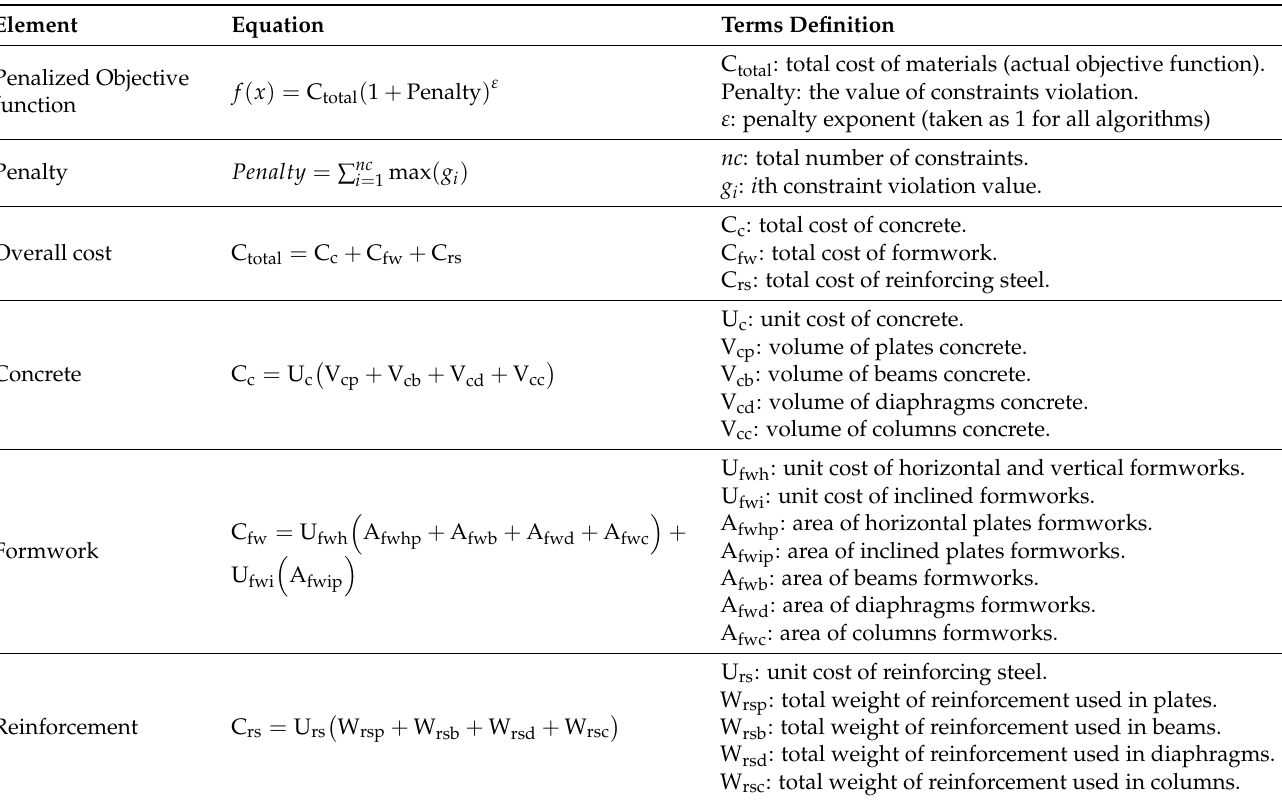
Table 6. Expressions used to calculate the objective function, penalty, and costs of each